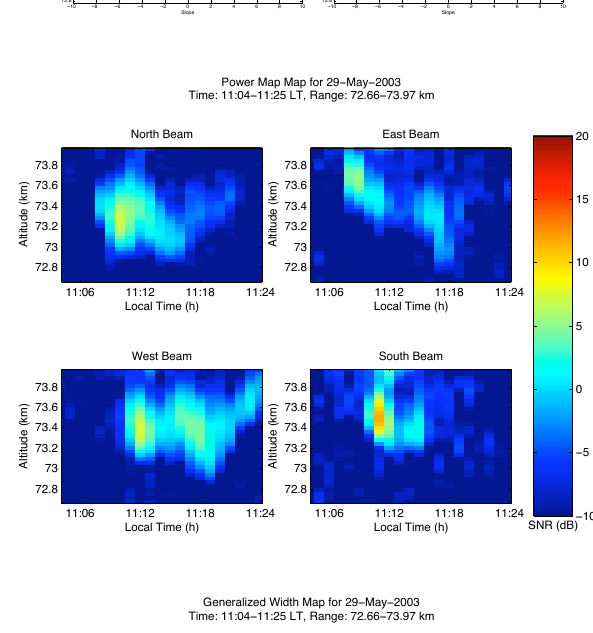
Fig. 18. SNR map in all four beams of event at 66.5 km on May 27, 2003 at 10:00 LT.